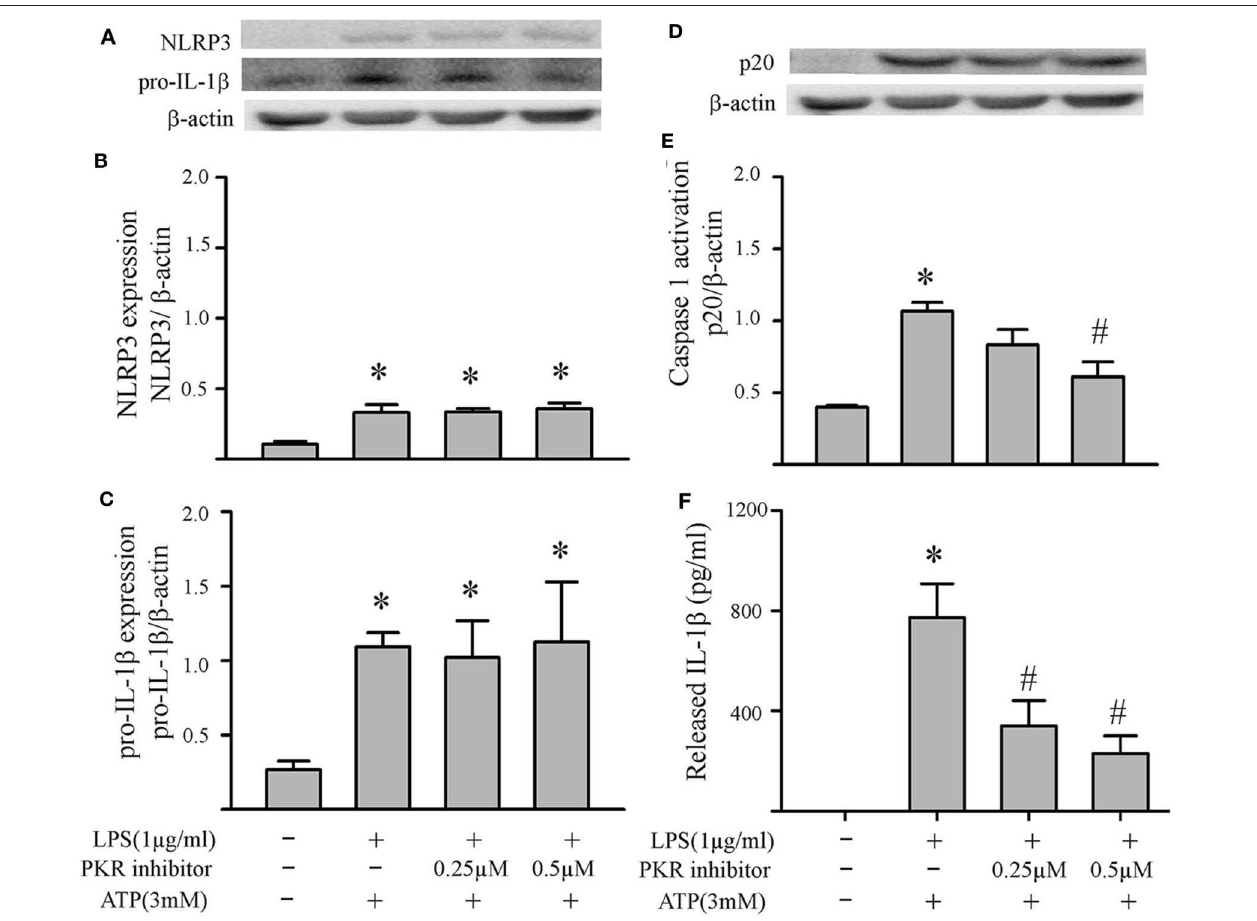
FIGURE 5 | Inhibition of PKR activity decreases ATP-induced activation of the NLRP3 inflammasome. Fibroblasts were challenged with LPS (1 µ g/mL) for 6h. Subsequently, the fibroblasts were treated with the PKR inhibitor C16 for 30min, followed by ATP (3mM) for an additional 30min. (A–C) NLRP3 and pro-IL-1 β protein levels were indices of inflammasome priming. Representative Western blots are shown in (A) and densitometric analyses in (B,C) . Of note, NLRP3 and pro-IL-1 β were increased after the initial LPS challenge, but the subsequent challenge with ATP was without effect on these two indices of inflammasome priming. (D–F) Caspase1 activation (p20) and IL-1 β protein levels in the supernatant were indices of inflammasome activation. Representative Western blot for caspase1 p20 is shown in (D) and densitometric analysis in (E) . Protein levels of IL-1 β were assessed in supernatants by ELISA. n = 3, * p < 0.05 as compared with control; # p < 0.05 as compared with LPS +